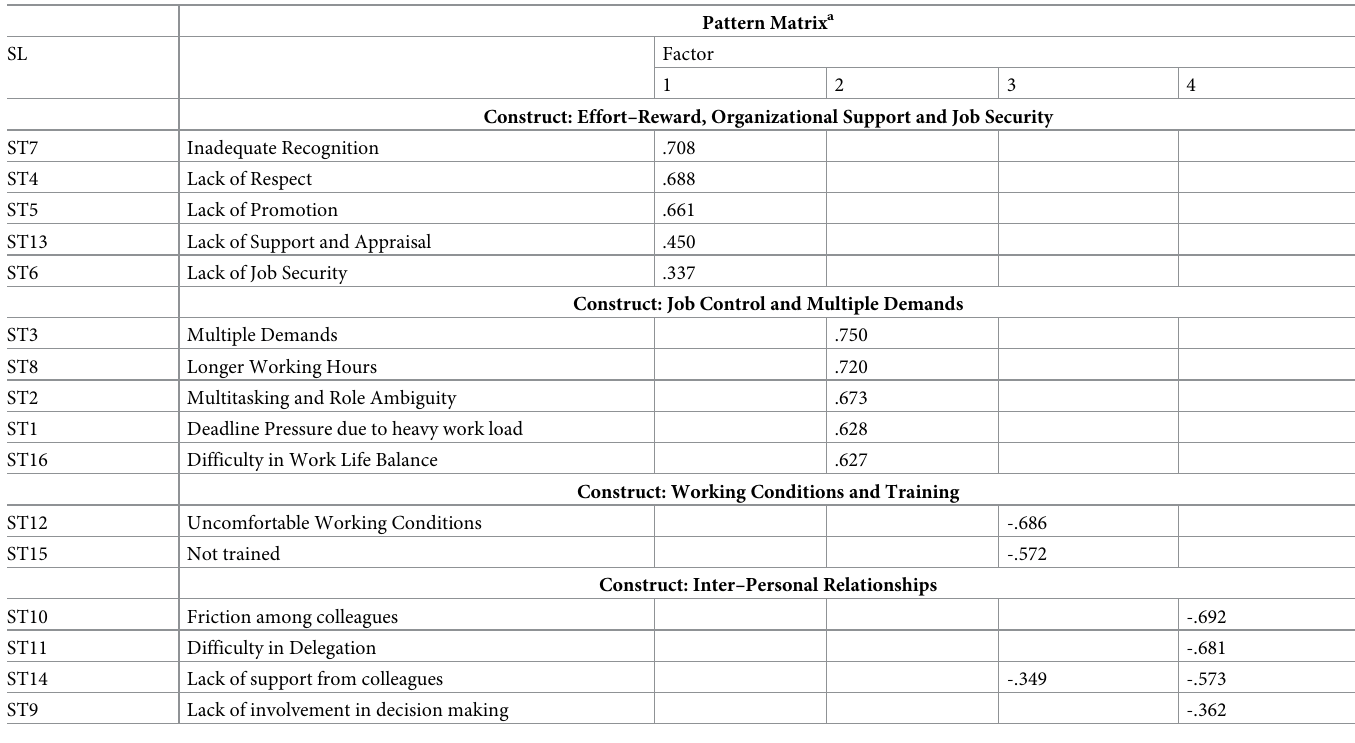
Table 2. Factor extraction matrix and